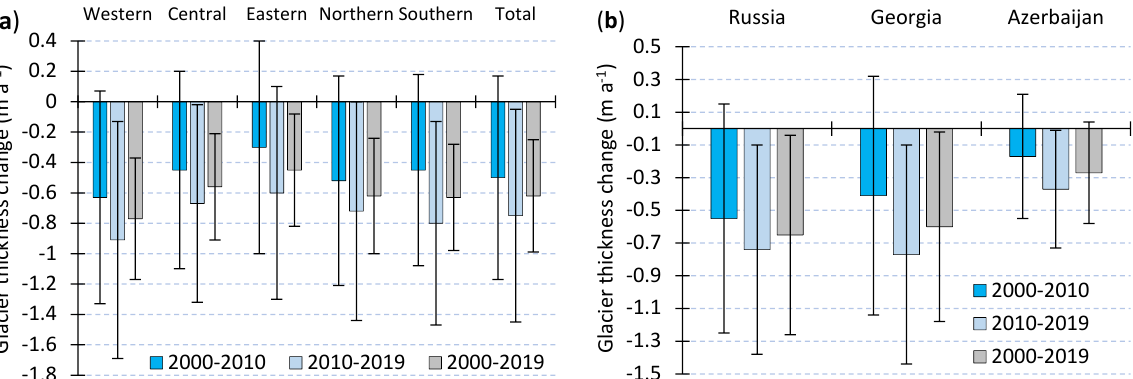
Figure A2. Changes in glacier thickness or surface elevation (m a − 1 ) for all Caucasus glaciers according to the regions (western, central, and eastern), slopes (northern, southern) ( a ), and countries ( b ) in 2000–2010, 2010–2019, and 2000–2019. Vertical stems showing an uncertainty estimation of the mean values.